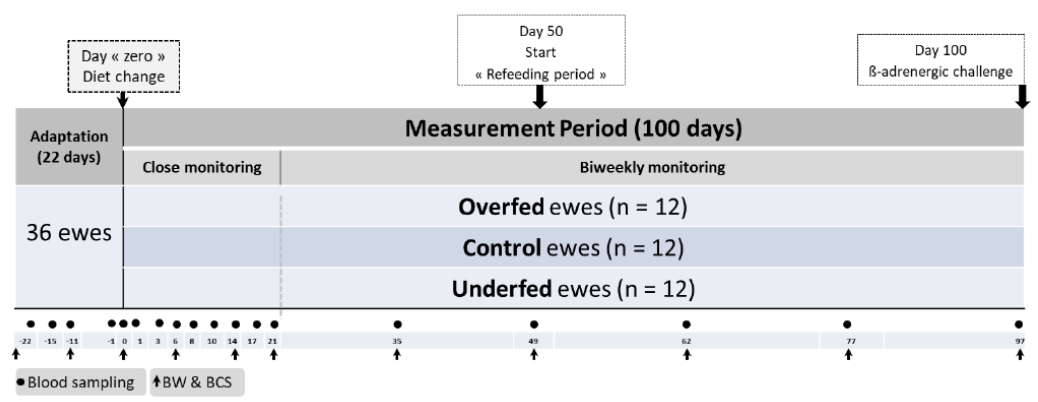
Figure 1. Schematic representation of the experimental design. The distribution of experimental ewes ( n = 36) subjected to three planes of nutrition and the body weight ( n = 11), blood ( n = 18) sampling points and a final ß-adrenergic challenge is illustrated. After 3 weeks of adaptation, the energy diet content was changed in the two extreme experimental treatments (overfed and underfed). The measurement period (100 days) consisted of two periods i.e., a dietary challenge (from 0 to 49 days) and refeeding (from 50 to 100 days) periods. Sampling was structured in close (3 weeks) and a more extended (biweekly) individual monitoring periods. BW: body weight and BCS: body condition score.